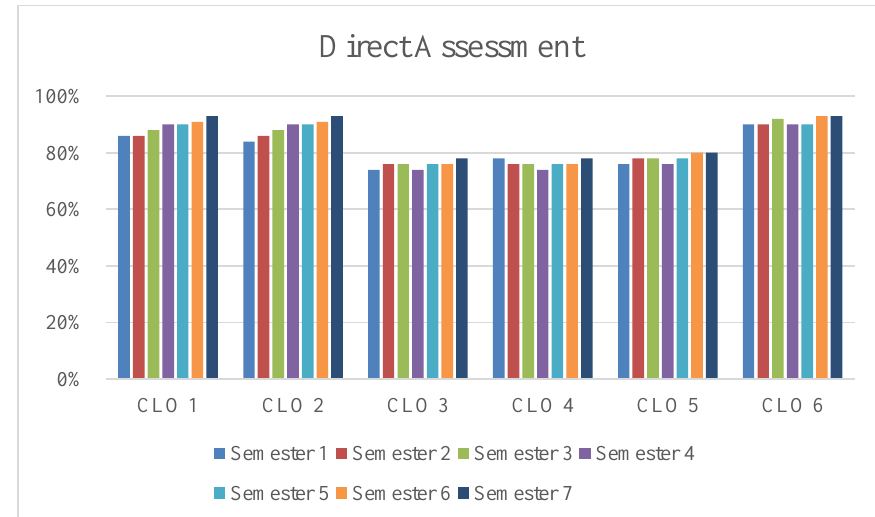
Fig. 4. The results of the indirect assessments over seven